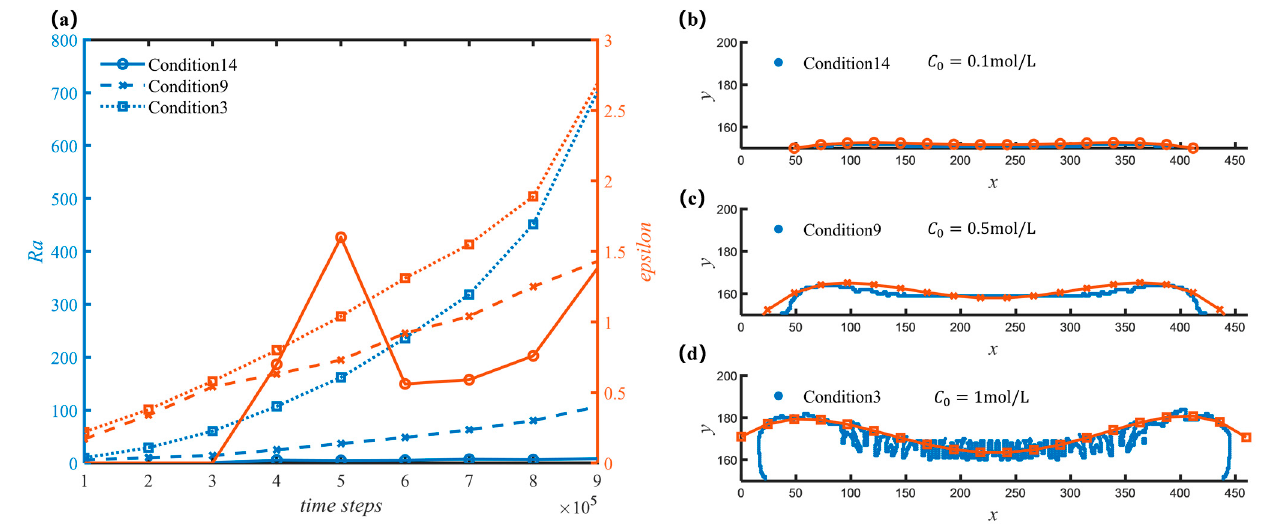
Figure 7. Morphology of sediments with different initial concentration. ( a ) Curves of roughness and overall trend with different working conditions; ( b ) Sediment profile and fit line for condition 14 at 500,000 time steps; ( c ) Sediment profile and fit line for condition 9 at 500,000 time steps; ( d ) Sediment profile and fit line for condition 3 at 500,000 time steps.